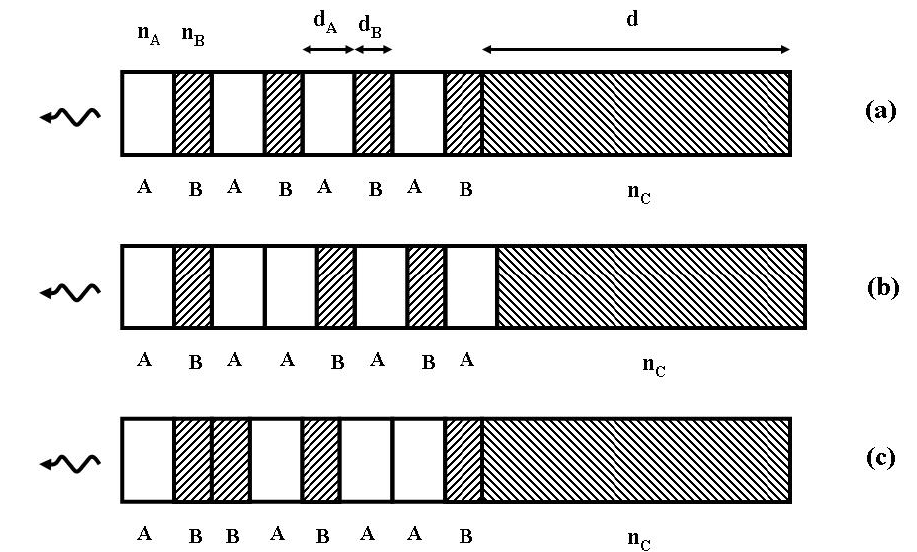
Figure 2. A multilayered stack (thin film) made of alternating layers of refractive indices n A (white layers) and n B (shadowed layers) coats a thick absorbing substrate of refraction index n C (complex). The entire structure is embedded in a medium, taken to be air ( n = 1). Different working regimes are obtained depending on the adopted layers distribution. In ( a ) the layers are periodically distributed, whereas in ( b ) and ( c ) they are